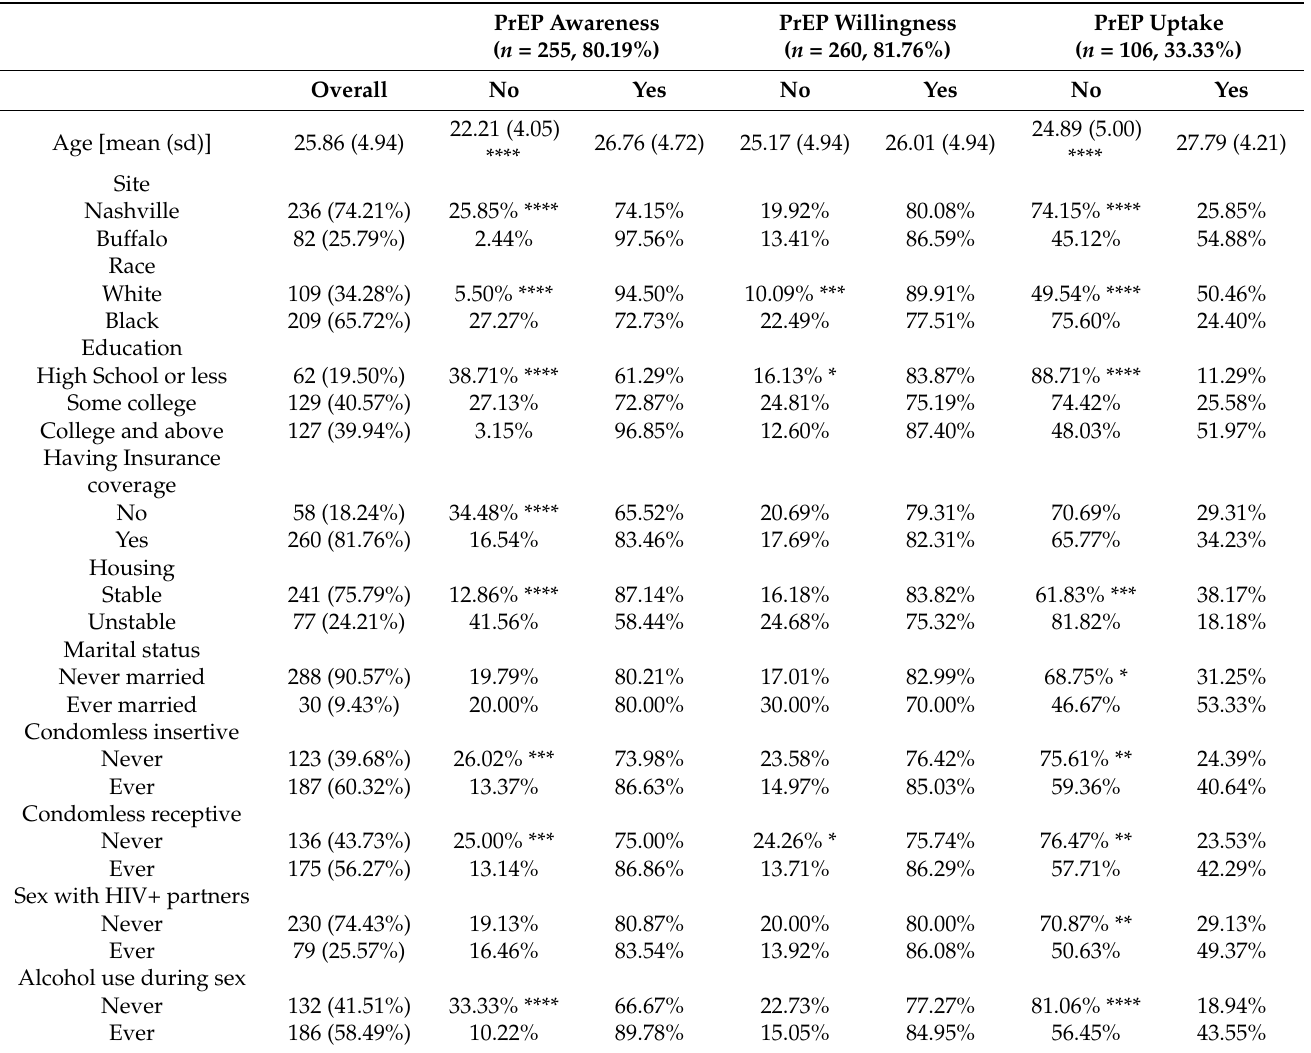
Table 1. Demographics and risk behaviors by PrEP cascade status ( n =